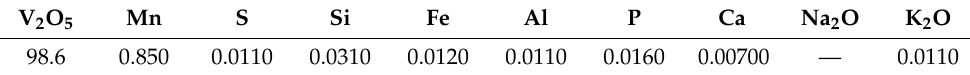
Table 7. Chemical composition of the vanadium pentoxide powder (wt. %).